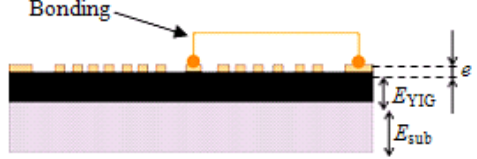
Figure 1: The spiral inductor structure with its magnetic core